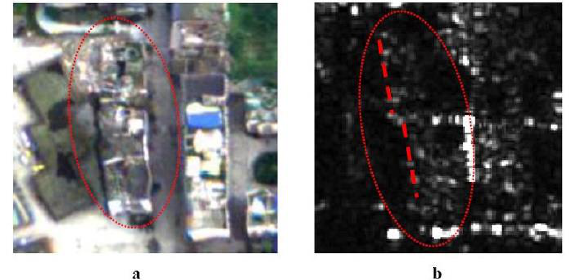
Figure 2. Offset of linear characteristic of a damaged building in post-event SAR image. a: aerial photo, b: TerraSAR-X spotlight